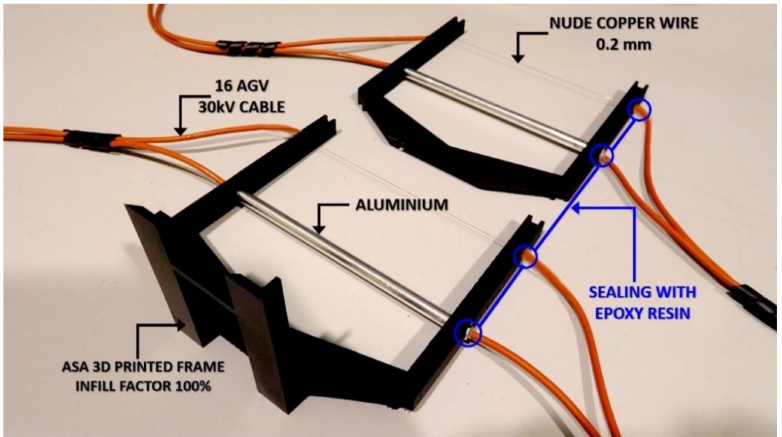
Figure 3. Detailed view of the